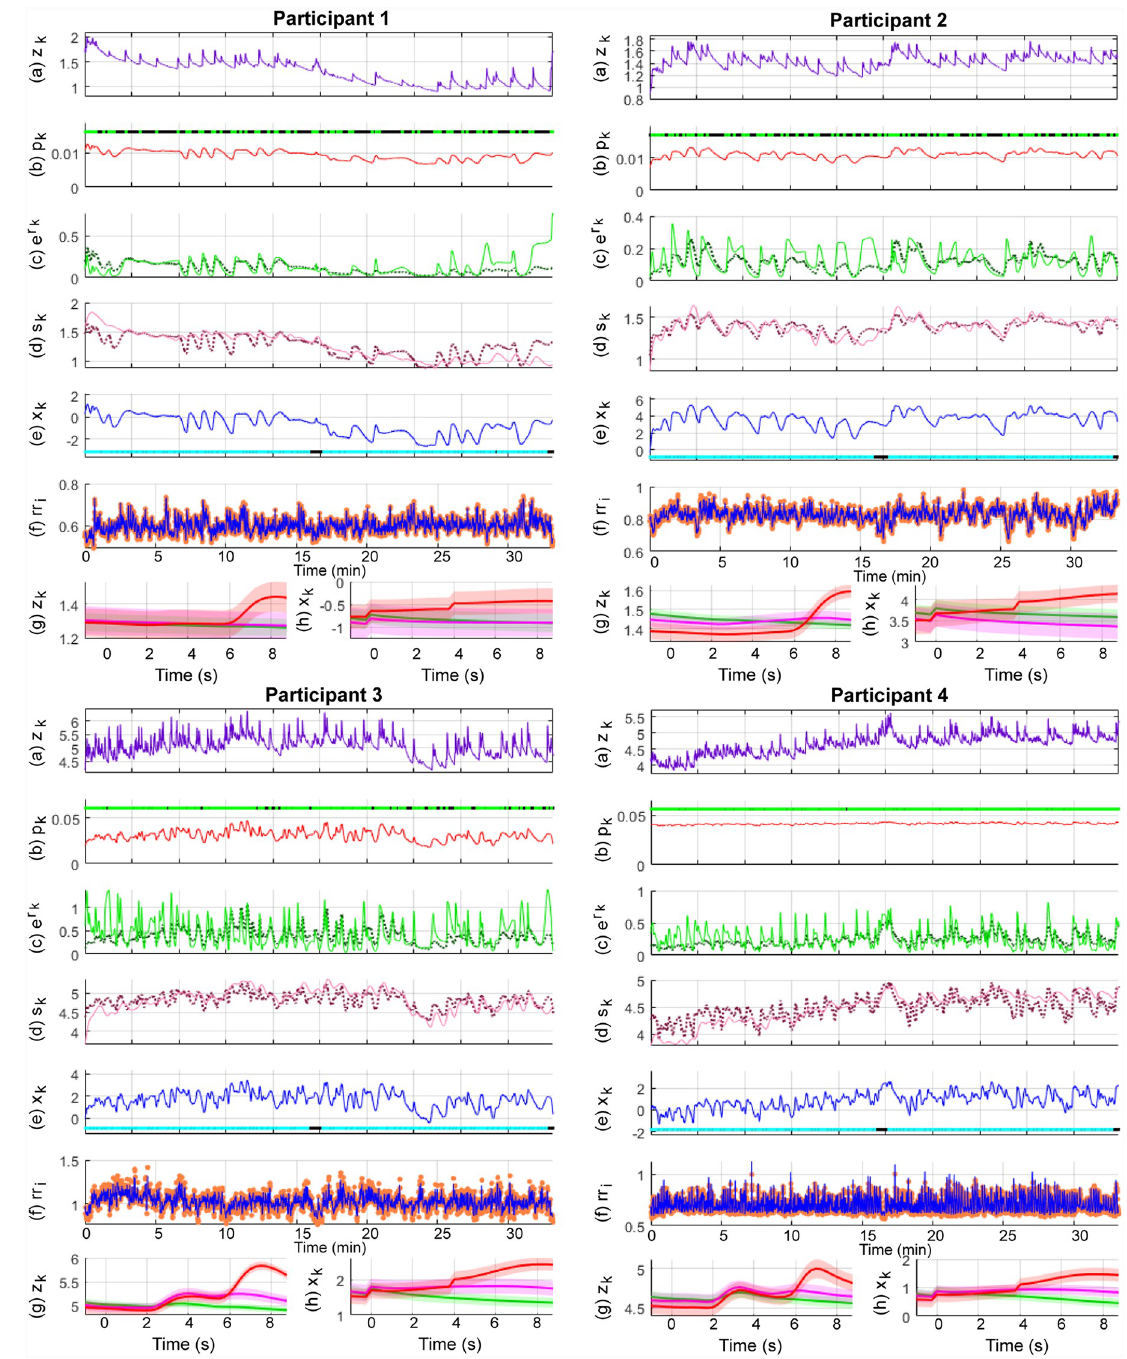
Fig 8. Sympathetic arousal estimation for participants 1-4 in the trace fear conditioning experiment. The sub-panels from top to bottom respectively depict, (a) the skin conductance signal z k ; (b) the presence or absence of SCR peaks (light green and black dots) and (red line); (c) the exponent of the phasic derived signal r (solid green line) and its the smoothed Bernoulli trial probability estimates of p k k estimate (dotted line); (d) the tonic part s k (solid light mauve line) and its estimate (dotted line); (e) the smoothed arousal state estimates of x k and the presence or absence of visual or electric stimuli (cyan and blacks dots); (f) the sequence of RR-intervals rr i (orange dots) and the estimated RR-interval mean μ (solid blue line); (g) a 10 s ERP-like skin conductance plot for the CS- (green), CS+ without a shock (mauve —CS+US-) and CS+ with the shock (red—CS+US+) trials; (h) 10 s ERP-like arousal state plots along with their confidence intervals.